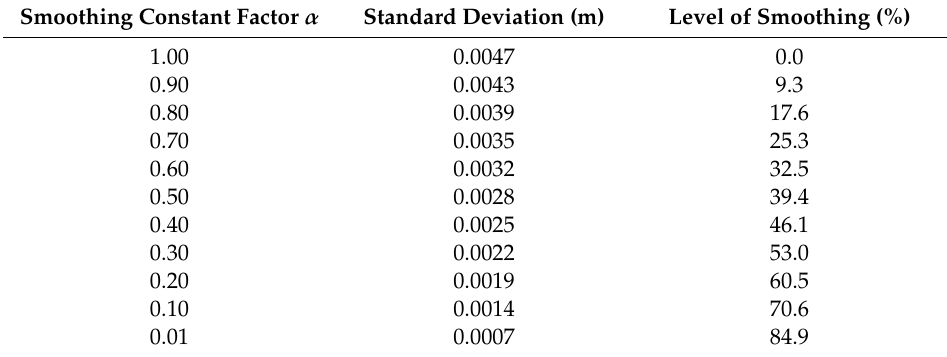
Figure 9. Comparison of the smoothing levels with different smoothing constant factors (case of hydrograph 1—downstream bridge). Table 3. Level of smoothing and standard deviation with different smoothing constant factors (used